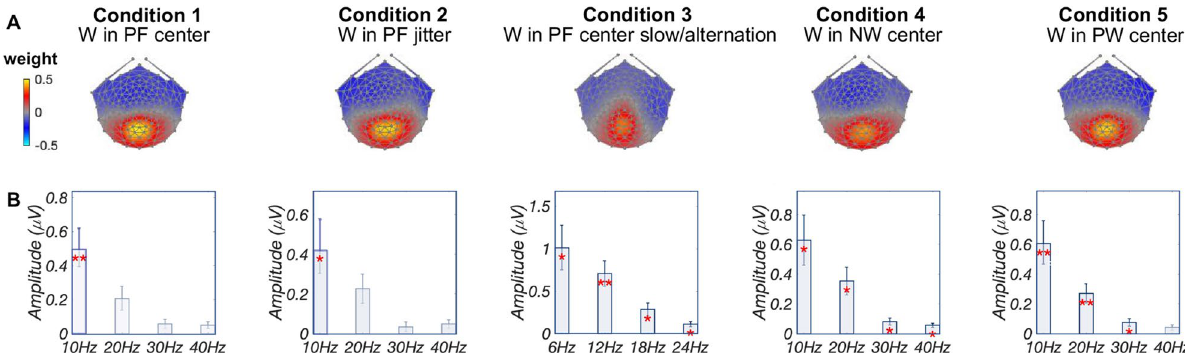
Figure 2. Base Analysis: low-level visual processing. ( A ) Topographic visualizations of the spatial filters for the maximally correlated component (RC1) for each condition. ( B ) Projected amplitude for each harmonic and condition in bar charts, * p FDR < 0.05 , ** p FDR < 0.01 . Figures were created using publicly available MATLAB (R2020a) code: https:// github. com/ svndl/ rcaEx